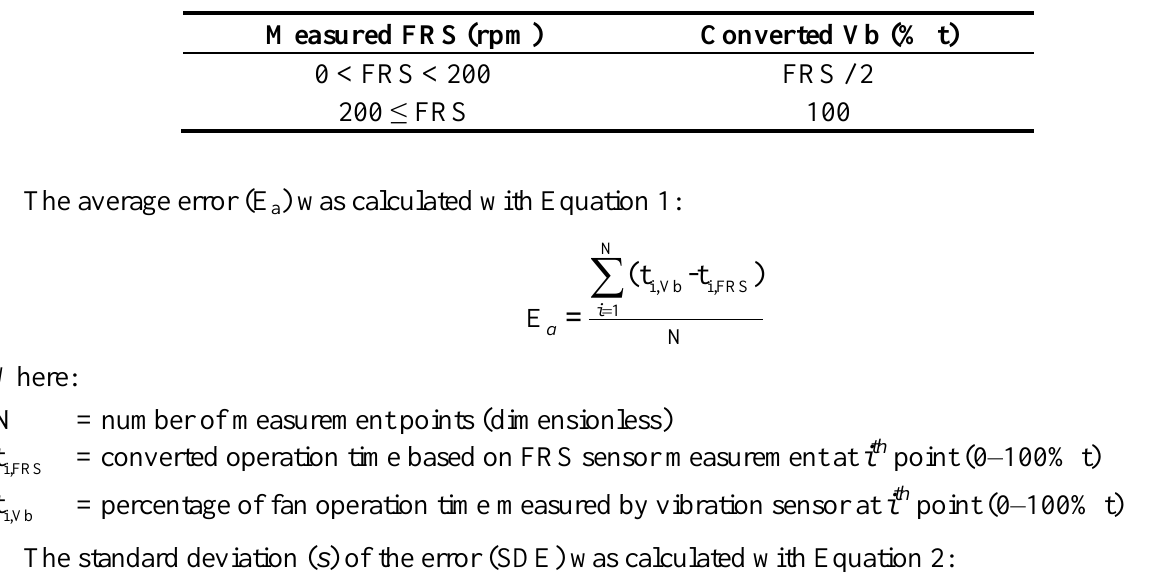
Table 1. Fan rotational speed (FRS) to vibration sensor (Vb) on/off time conversion